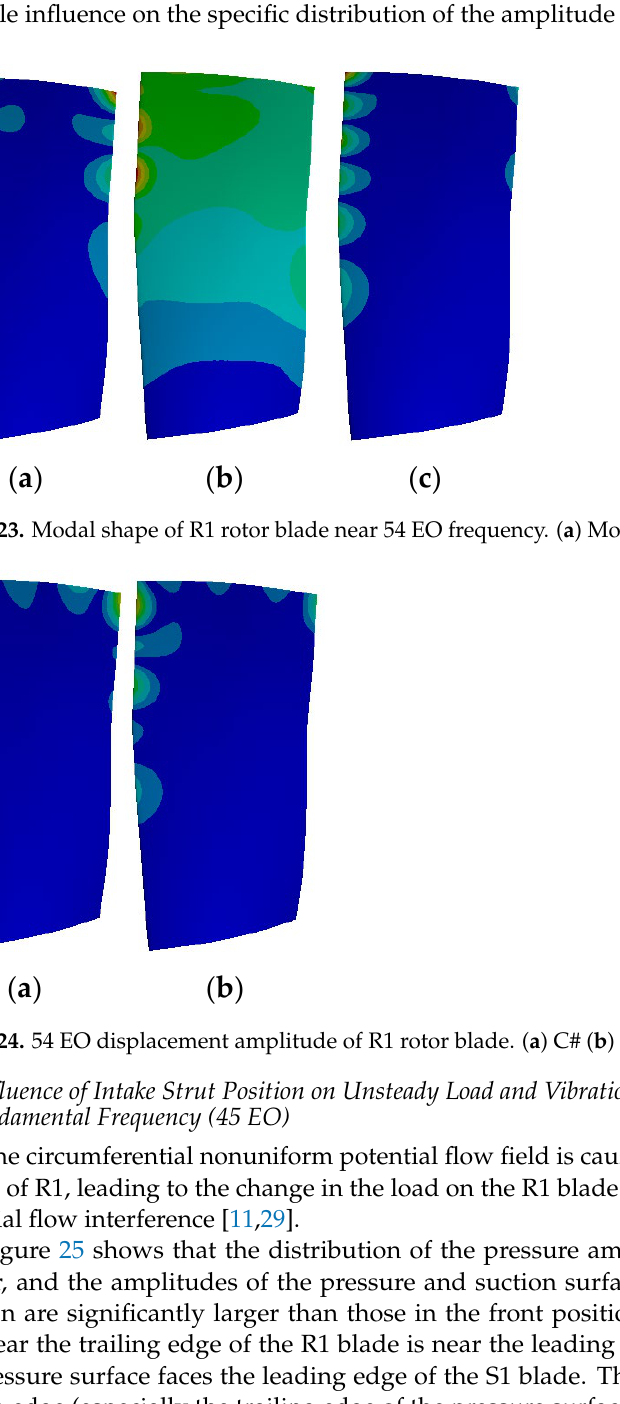
( b ) Figure 25. 45 EO amplitude of static pressure on the surface of R1 rotor blade (red line is shock wave). ( a ) C# ( b ) M#. In Figure 25, the pressure amplitude distribution at the 40–90% blade span behind the suction surface shock wave is significantly different between the two calculation ex- amples. To analyze the reasons, Figure 26 shows the distribution of the time-average value under static pressure at the 50% blade span on the R1/S1 interface, which reflects the in- fluence of the potential flow propagating upstream from the downstream S1 blade. In the two examples, the circumferential distribution of the time-average value under static pres- sure is basically the same, and the change in the position of the struts does not significantly